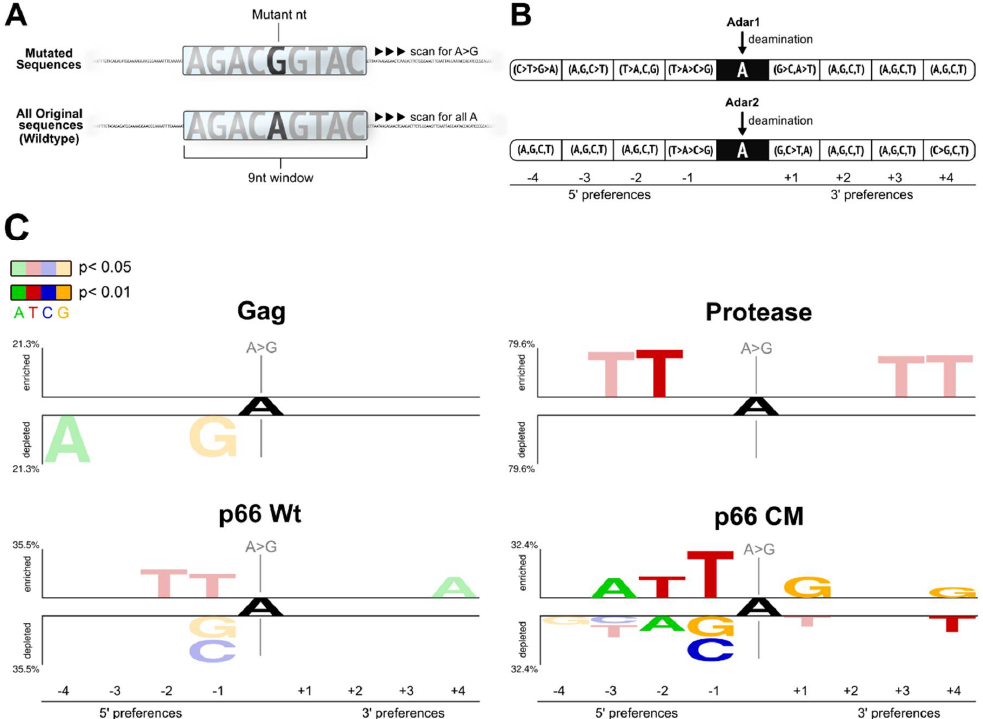
Figure 5. Two Sample logo analysis of HIV-1 Gag, protease, RT p66 (p66 Wt) and Codon Mutated RT (p66 CM). ( A ) The flanking sequence preferences 4 nt upstream and downstream of all ‘A to G’ mutations were determined from the identified adenosine mutations within a 9 nt sliding window. ( B ) A re-representation of the result from [28] on the studied neighbor sequence preferences of ADAR1 and 2 isoforms. Base preferences are shown with inequality signs, where the identity of the base did not significantly contribute to the editing of the 4 bases are delimited by commas. ( C ) Two Sample Logos analysis of the flanking sequences around the ‘A to G ‘mutation sites. Only significantly enriched and depleted neighboring nucleotides flanking A to G mutations are shown. Bases were colored opaque when p < 0.01, and translucent when p < 0.05. Statistics: two sample t-test without Bonferroni correction.